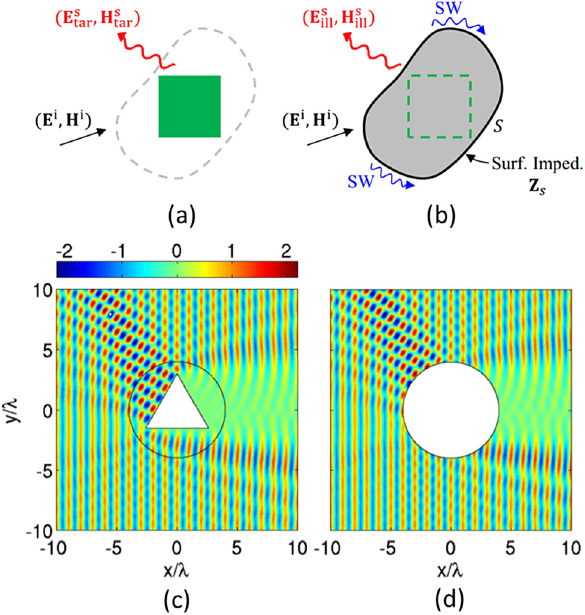
Figure 29: (Reprinted with permission from Ref. [85]). (a) and (b) Designofanillusiondevice.(a)Atargetcon fi gurationwithscattered fi elds ( E s , H s ). (b) An illusion device having an impenetrable tar tar bounding surface S with scattered fi elds ( E s , H s ) on and outside S. ill ill (c)and(d)Distributionsof E z ( x , y )inV/mforatriangularPECcylinder and its illusion device. The target is a cylinder of an equilateral triangular cross section with a side of 3 √ 3 λ . (c) An E- fi eld snapshot for the target cylinder. The black circle indicates the imaginary contourofthe illusiondeviceto bedesigned.(d)An E- fi eldsnapshot for the cylindrical illusion device of a = 4 λ .